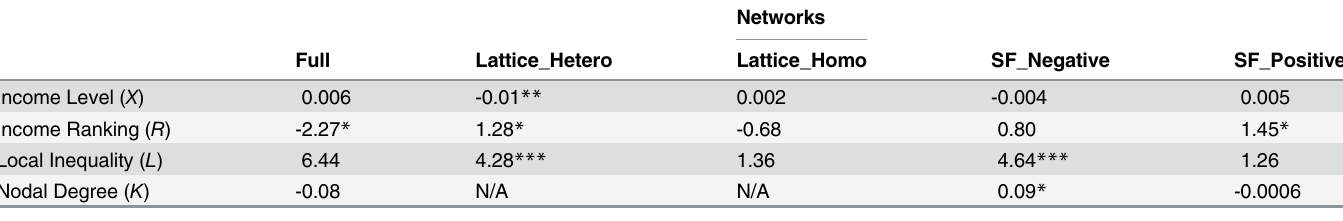
Table 1. Hurdle Regression Model on Giving Decisions (Probability of